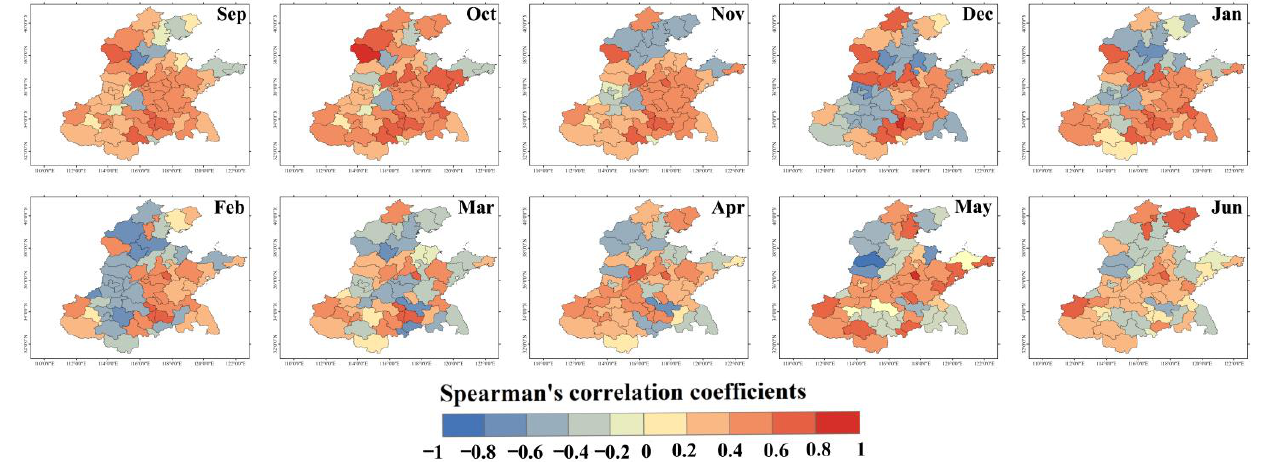
Figure 7. Spatial distribution of the mean correlation coefficients of the SPEI and SYRS in 55 cities during winter wheat growth in the NCP from 2001 to 2015.